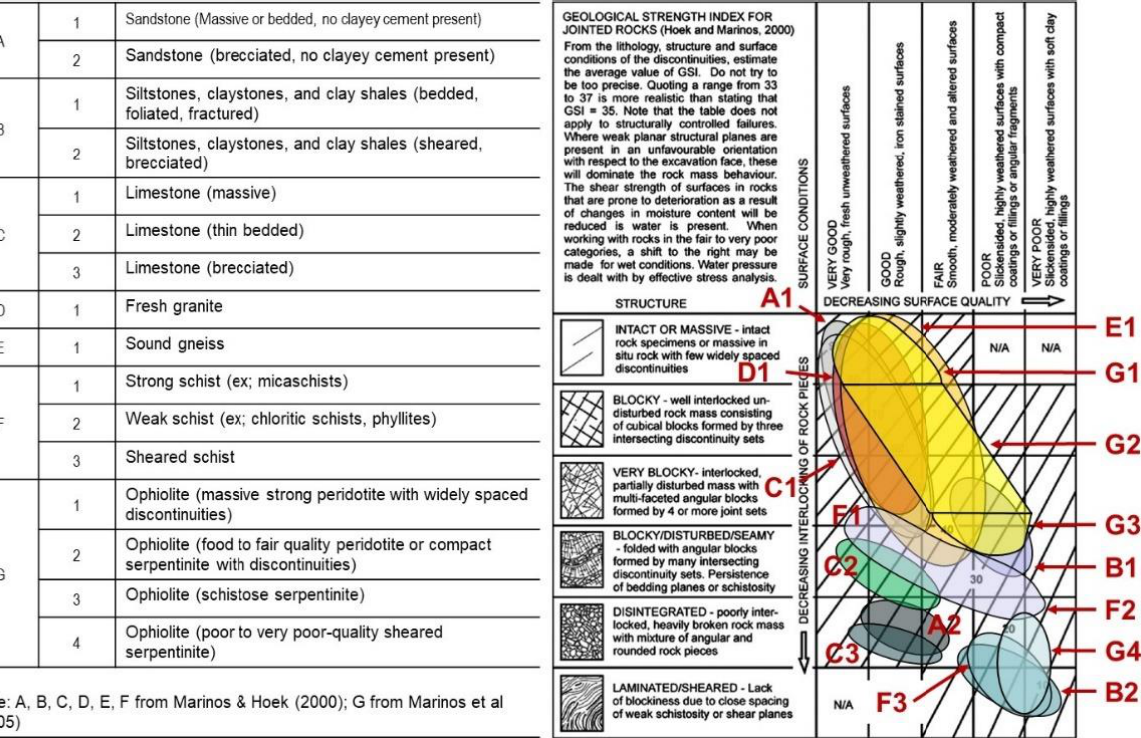
Figure 6. GSI chart with superimposed geology of different case studies (modified from [1,18,19]).